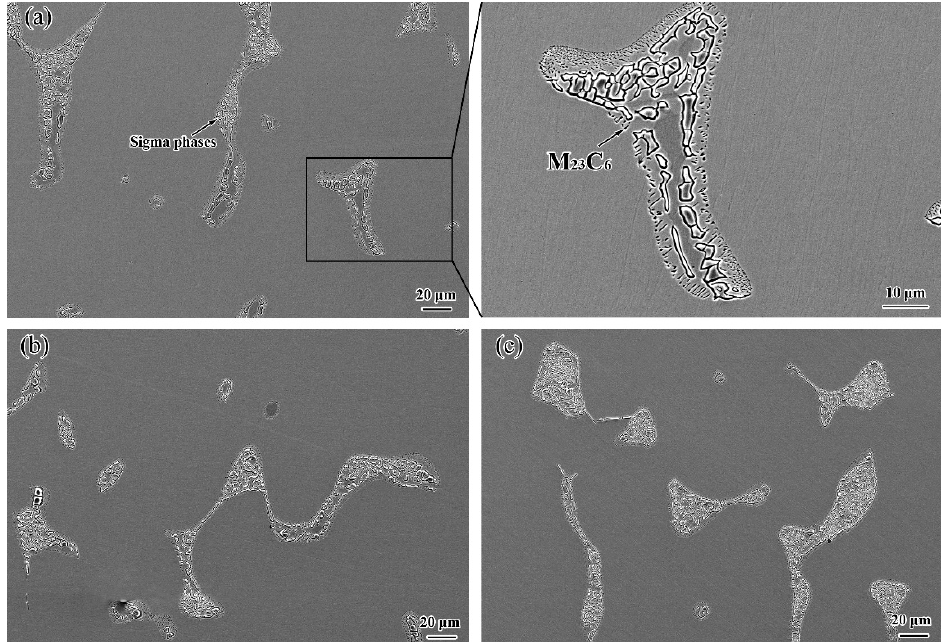
Figure 6. SEM microstructures of Z3CN20.09M specimens aged at 750 °C for different durations: ( a )